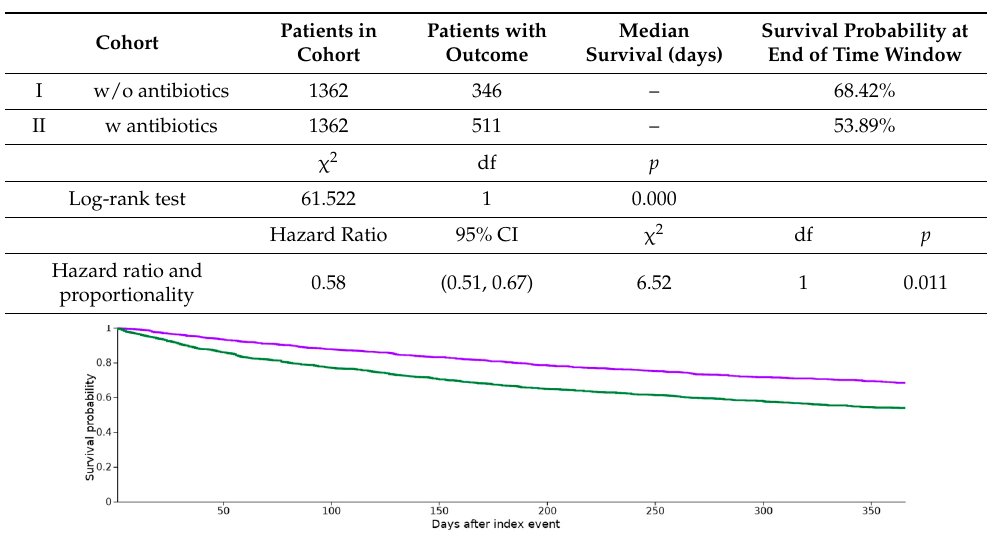
Table 3. Kaplan–Meier survival analysis for one year (purple: cohort I, green: cohort II).